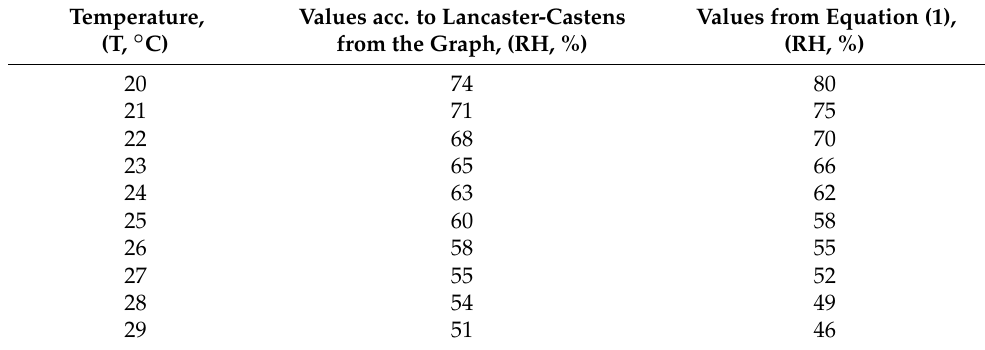
Values from Equation (1), (RH, %)